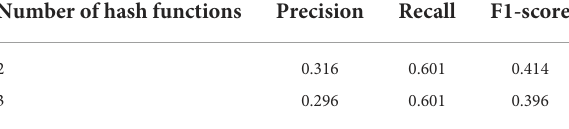
TABLE 3 Effect of different number of hash